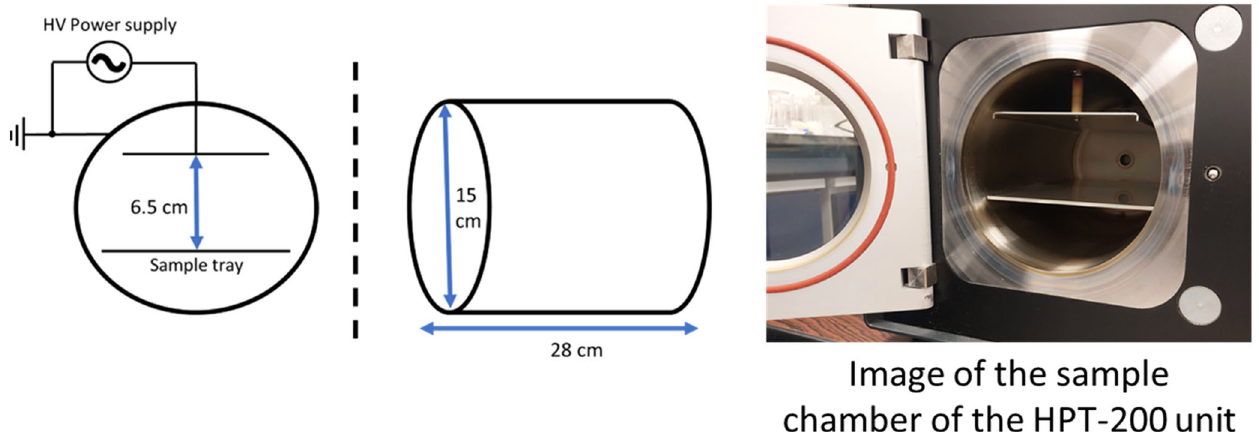
Fig. 2 Schematic showing the dimension of the plasma chamber in Henniker HPT-200. Left: the front view of the chamber; middle: the side view of the chamber; right: image of the sample chamber of the HPT-200